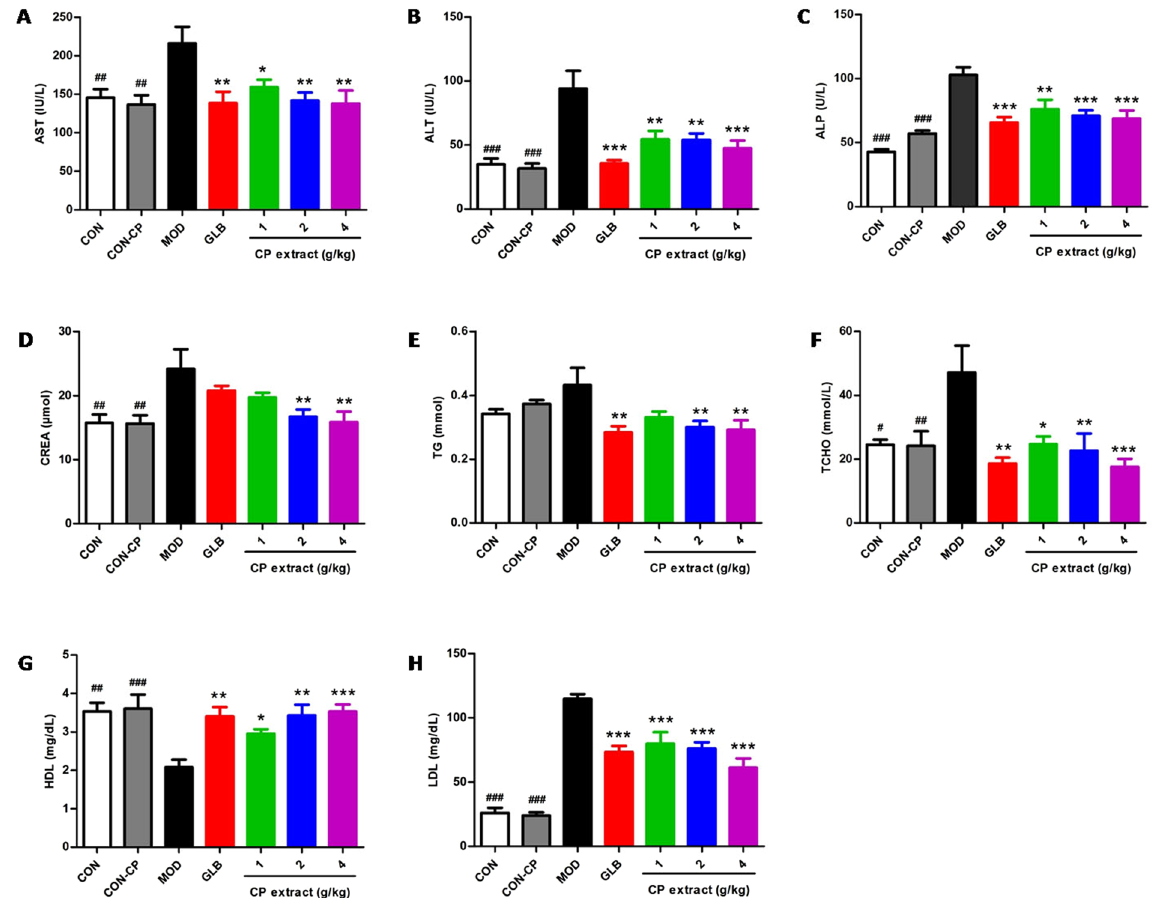
Figure 9. The effects of CP extract on the blood biochemical changes of diabetic mice. The type 2 diabetic mice were induced by feeding with high-fat diet for 4 weeks and then injecting intraperitoneally with 25 mg/kg STZ for 3 days consecutively. The diabetic mice with consecutive 7-day hyperglycemia (11 mmol/L or greater) were selected for the experiment and then CP extract or glibenclamide were administered to mice for consecutive 5 weeks. At the end of experiment, mice were sacrificed. The samples of blood were collected and relevant blood biochemicals in serum were measured by using corresponding commercially available kits. Blood ( A ) ALT, ( B ) AST, ( C ) ALP, ( D ) CREA, ( E )TG, ( F ) TCHO, ( G ) LDL and ( H ) HDL levels. All data are presented as means ± SEM (n = 8). # p < 0.05, ## p < 0.01 and ### p < 0.001, diabetic model group compared with non- diabetic groups; * p < 0.05, ** p < 0.01 and *** p < 0.001, compared with diabetic model group. CON: non-diabetic control group; CON-CP: CP extract-treated non-diabetic control group; MOD: diabetic model group; GLB: glibenclamide-treated diabetic